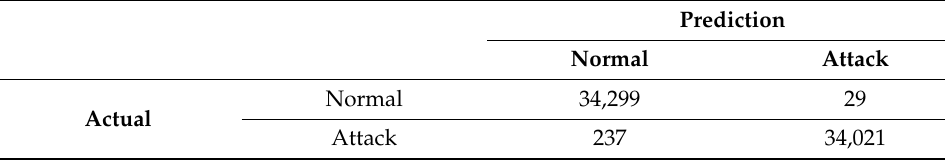
Table 10. Confusion matrix for the binary class